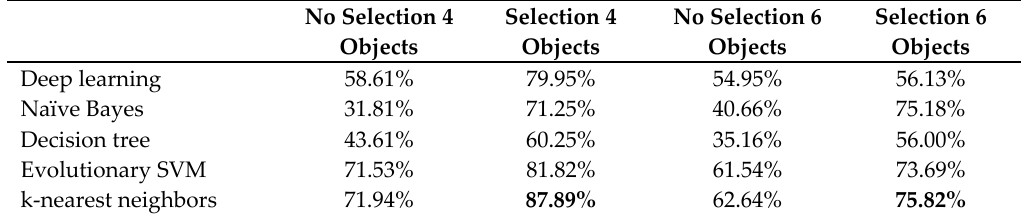
Table 1. Object recognition rate with and without tactile imprints selection for simulated data.